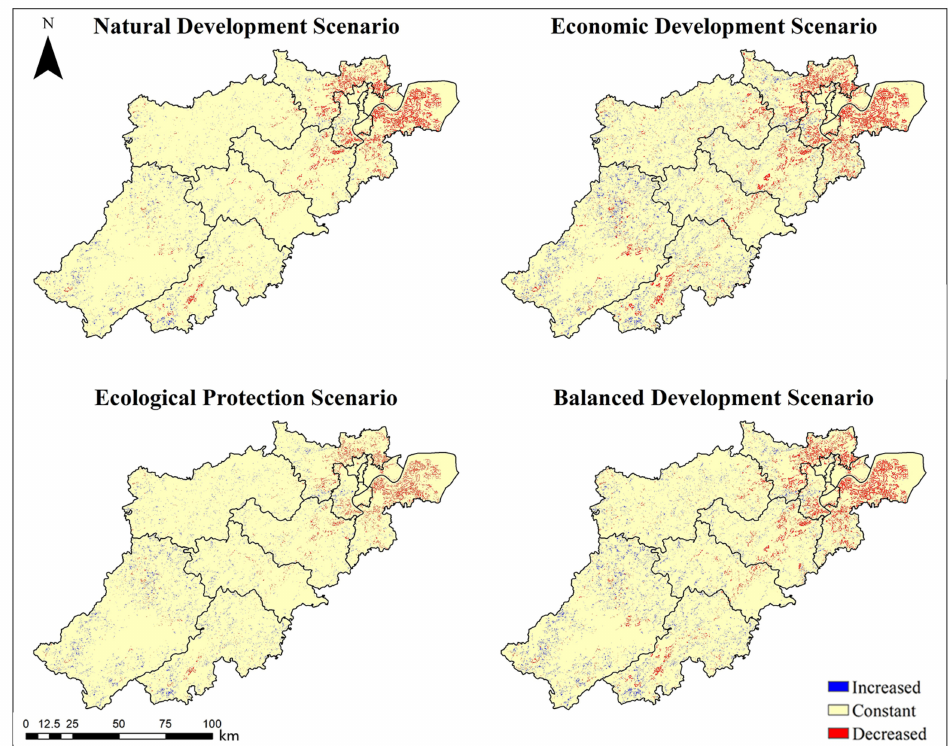
Figure 8. Prediction of the carbon storage change in Hangzhou under the four scenarios in 2030.